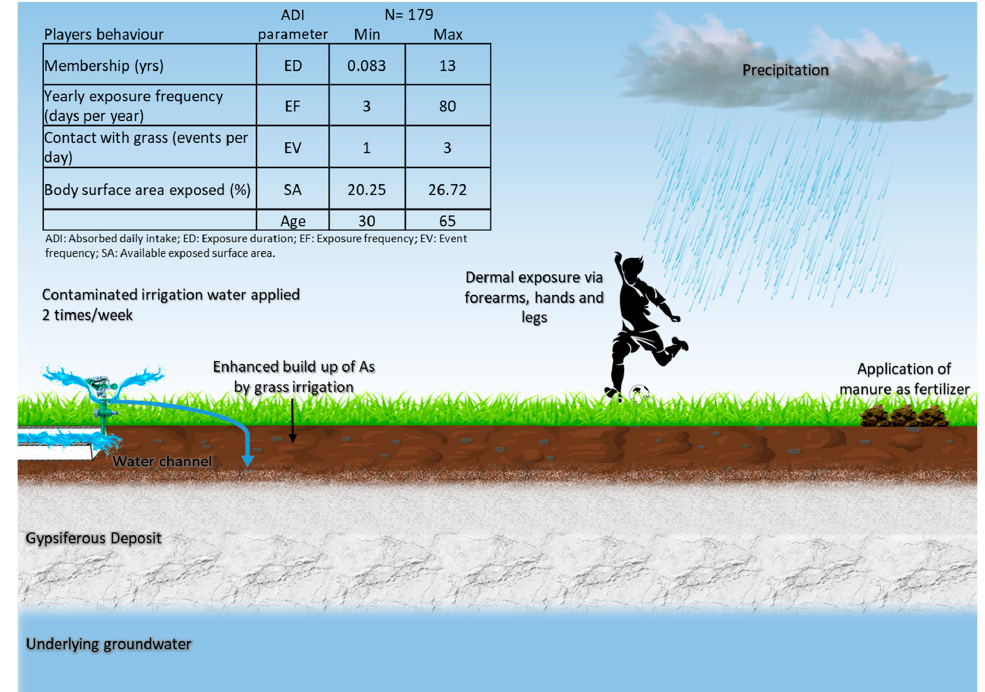
Figure 1. Refined conceptual model showing the pathway of concern with respect to As contamination: dermal absorption via contact with soil. Soccer statistics are based on 179 questionnaires acquired out of 201 from members of the soccer club under study.